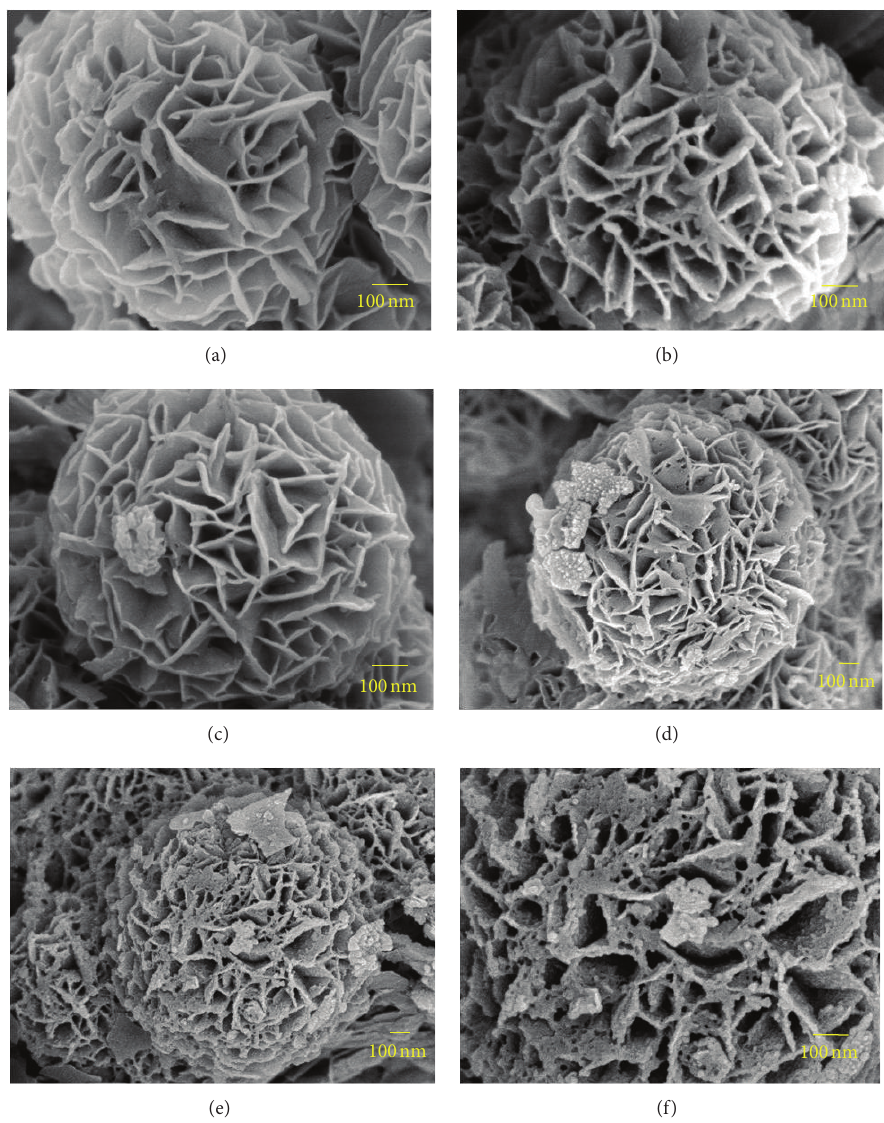
Figure 5: FE-SEM images of (a) ZnS, (b) 15N/ZnS, (c) 30N/ZnS, (d) 70N/ZnS, and (e) 140N/ZnS photocatalysts.